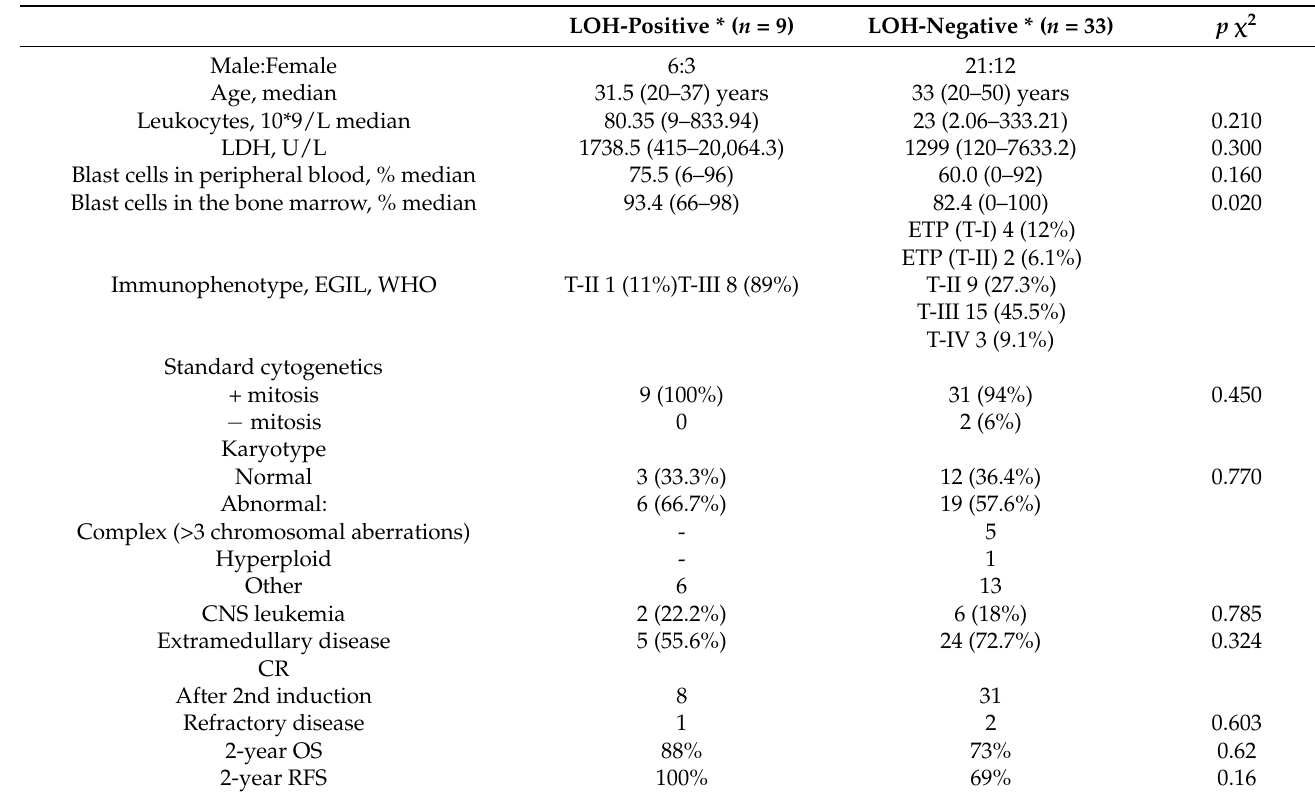
Table 2. The main characteristics of B-ALL patients according to the LOH status. p -value from χ 2 was used to estimate significance for the tables of 2 × 2.